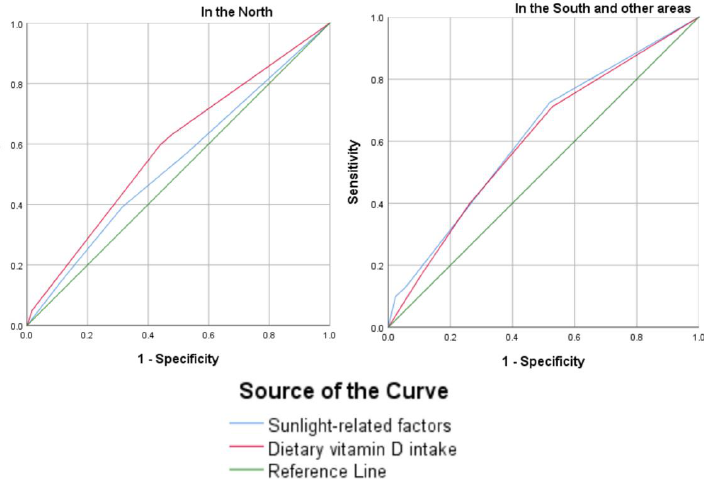
Figure 2. Contribution of sunlight-related factors and dietary vitamin D intake to vitamin D status in different regions of Taiwan.